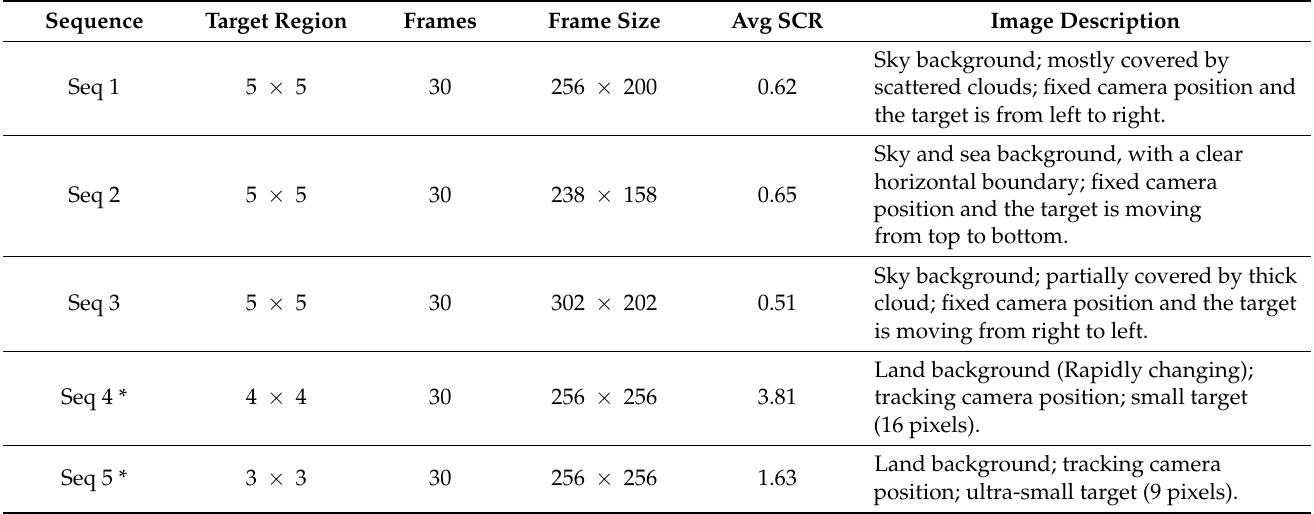
Table 1. The properties of the image sequences. “*” means to converted to grey-scale images in the step “Image